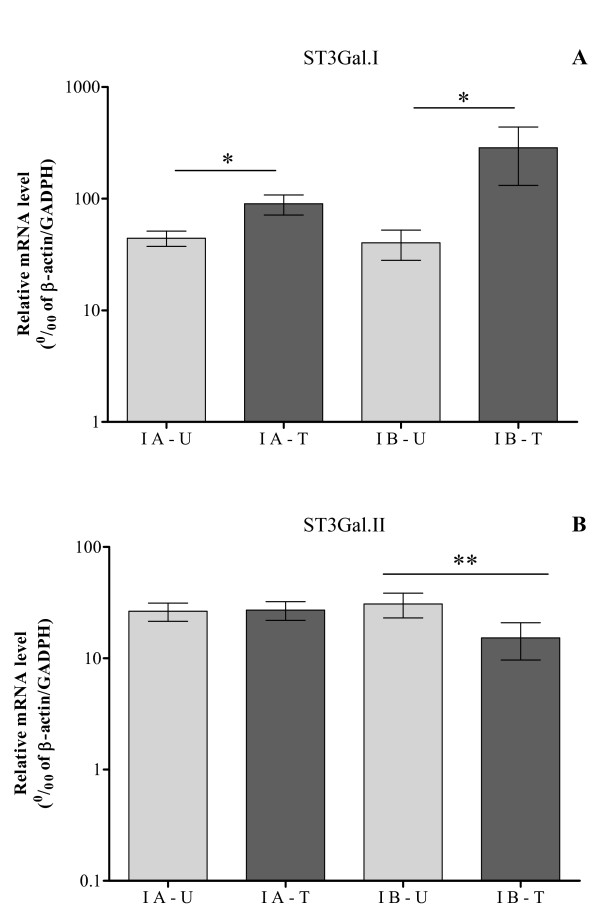
Nonmuscle-invasive bladder cancers with tendency for recurrence show slight increased expression of ST3Gal I and ST3Gal.II, compared with normal urothelium. Only patients with nonmuscle-invasive bladder cancer were considered: without recurrence within a minimal period of 12 months following TURBT (IA) and experiencing recurrence in that period (IB). The relative mRNA levels of ST3Gal.I (A) and ST3Gal.II (B) genes were analyzed in bladder tumor (T) tissue and corresponding normal urothelium (U), by Real Time RT-PCR, as described in the Methods section. Values infer the number of mRNA molecules of a certain gene per 1000 molecules of the average of the endogenous controls (β-actin and GAPDH). ST3Gal.I expression is significantly increased in tissue of both subgroups of nonmuscle-invasive bladder cancer, compared with the corresponding urothelium (p < 0.05), while ST3Gal.II expression is significantly decreased in tumors from group IB patients, compared with the corresponding urothelium (p < 0.01).